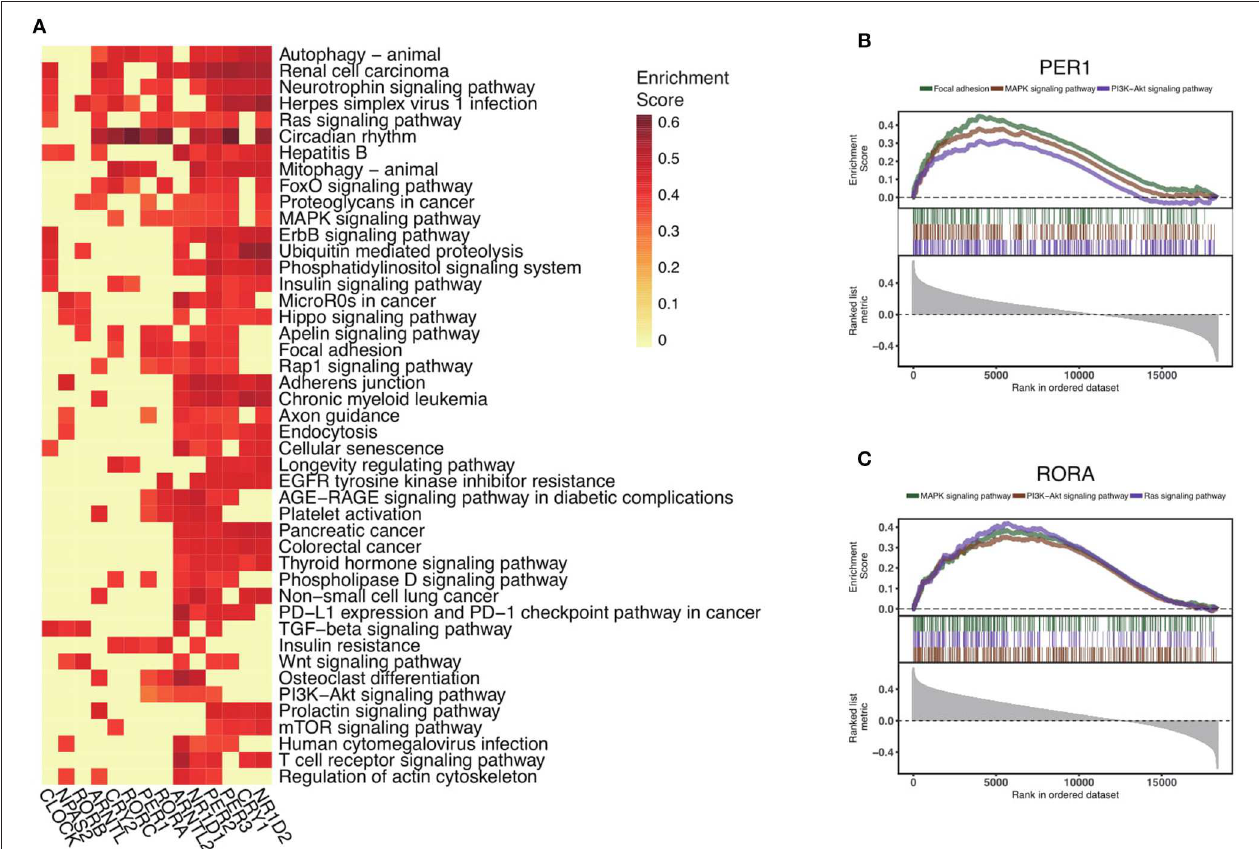
FIGURE 4 | Circadian clock widely impacts signaling pathways in pan-cancer. (A) Rankings of pathways linked with the circadian clock in cancers. Signaling pathways were ranked by the frequency of correlation with core clock genes. (B) Significantly enriched pathways of PER1 and (C) RORA. Gene set enrichment analysis of Spearman’s rho rankings were